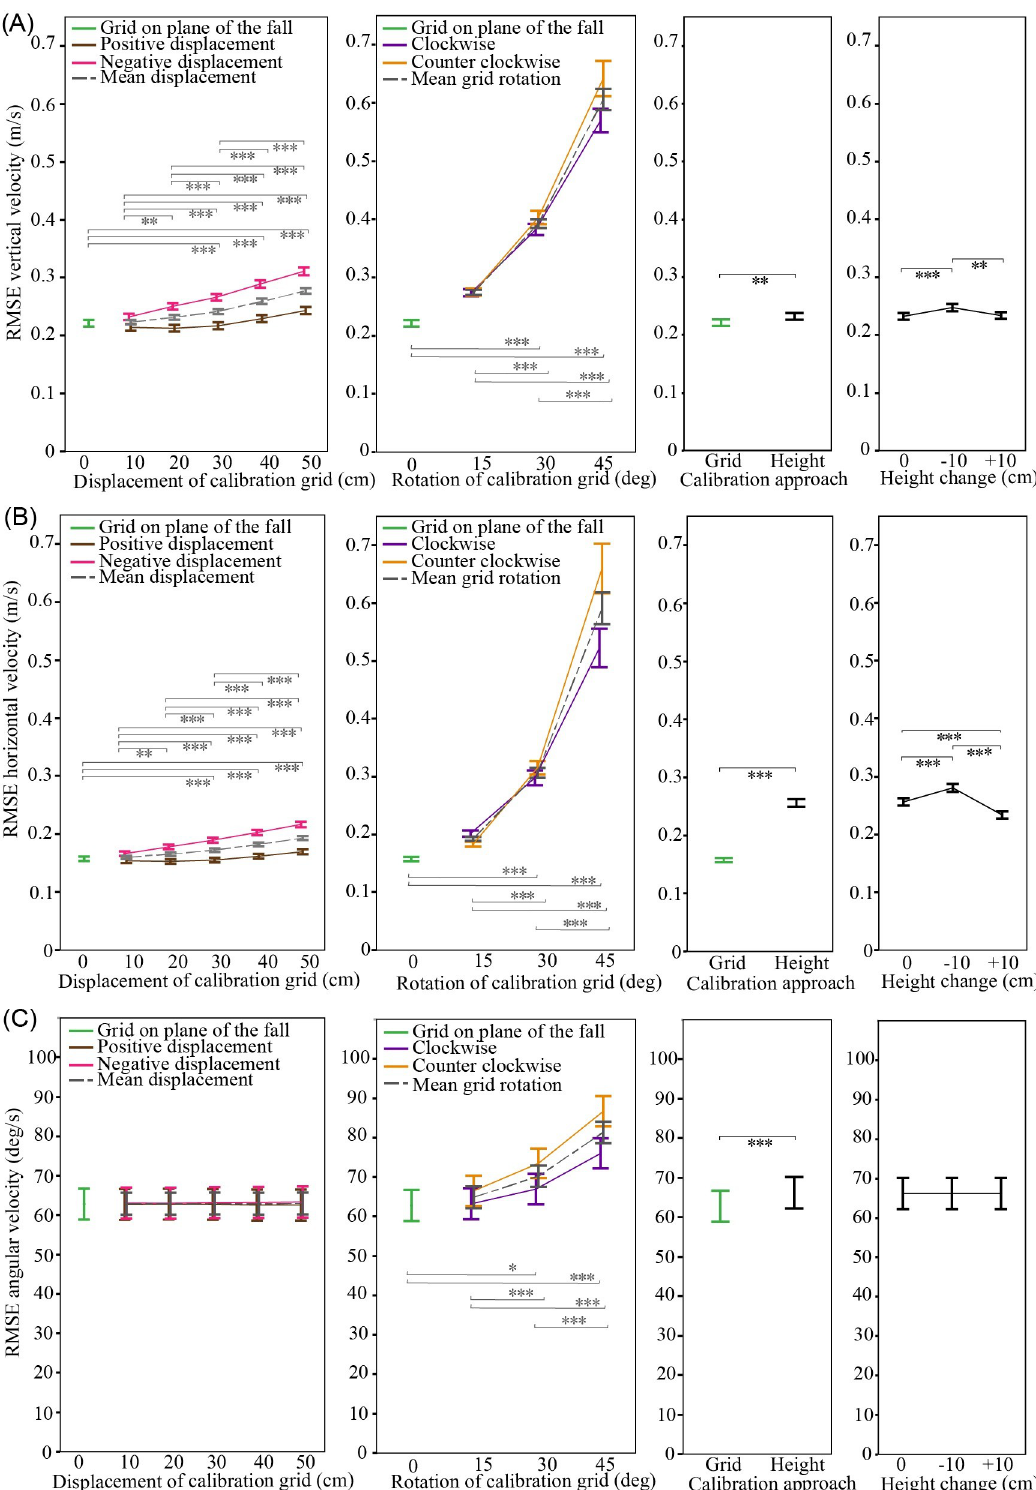
Fig 9. Effect of calibration technique on the accuracy of Kinovea estimates. (A) Vertical velocity, (B) horizontal velocity, and (C) angular velocity. Root mean square errors (RMSE) are from comparison between Qualisys ground truth signals and Kinovea estimates from the 90 deg camera angle, and filtering of position data with a 10 Hz cut-off frequency. Data points show mean